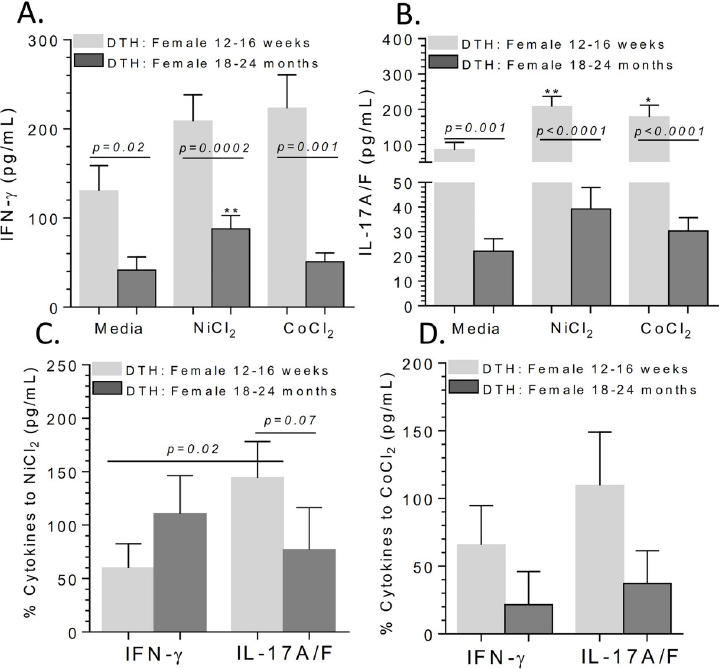
Fig 8. IL-17 production is reduced in aged (vs young) metal-DTH female mice. Lymphocytes were restimulated in vitro with soluble metal ions for 4 days and (A) IFN-gamma and (B) IL-17A/F production were measured from supernatants by ELISA. Percentage increase of lymphocyte cytokine production of IFN-gamma or IL-17A/F in response to (C) Ni or (C) Co metal ion challenge; calculated using cytokine production to metal ions vs. respective negative control media cell cytokine production. Data represents two independent experiments with n = 4–5 mice/ group in each experiment. Data are shown as the mean ± SEM. Statistical significance was determined by unpaired Mann-Whitney